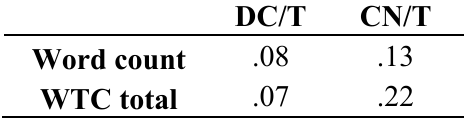
Correlations among Michelle’s topic measures and complexity